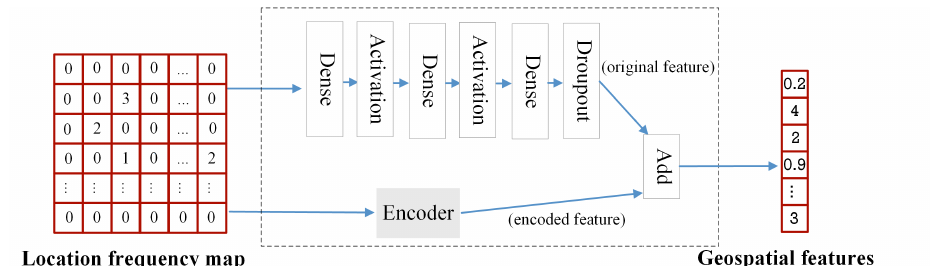
Figure 3. The network module for generation of geospatial